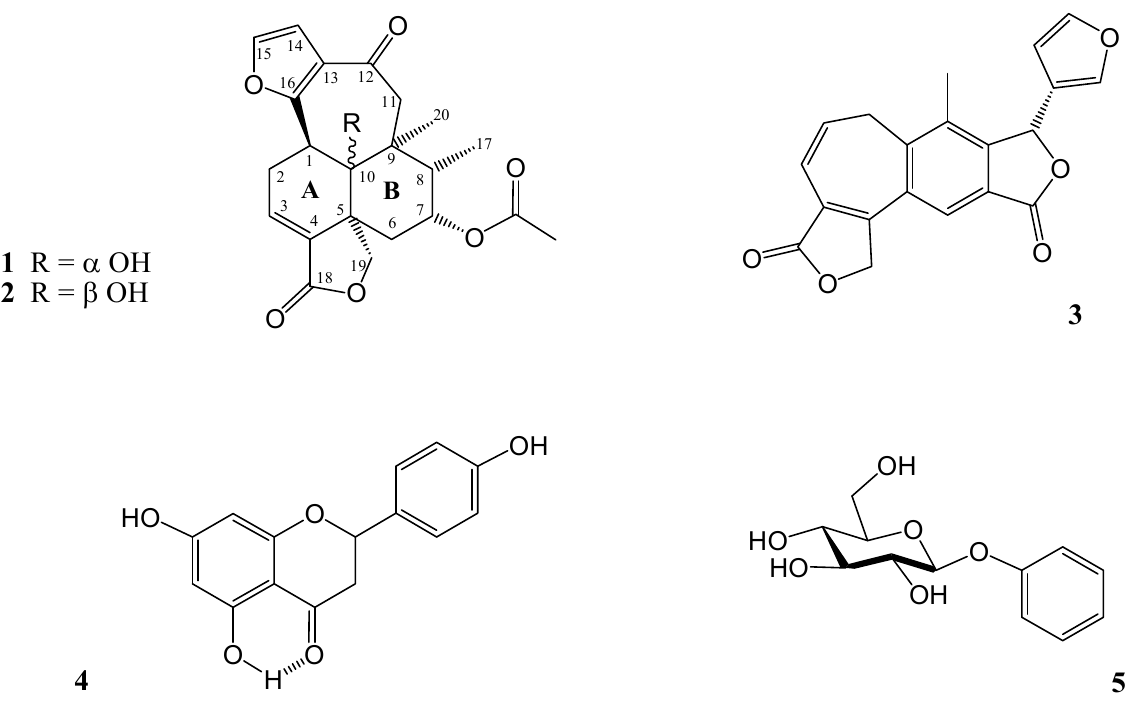
Figure 1. Products isolated from S. mexicana var. mexicana